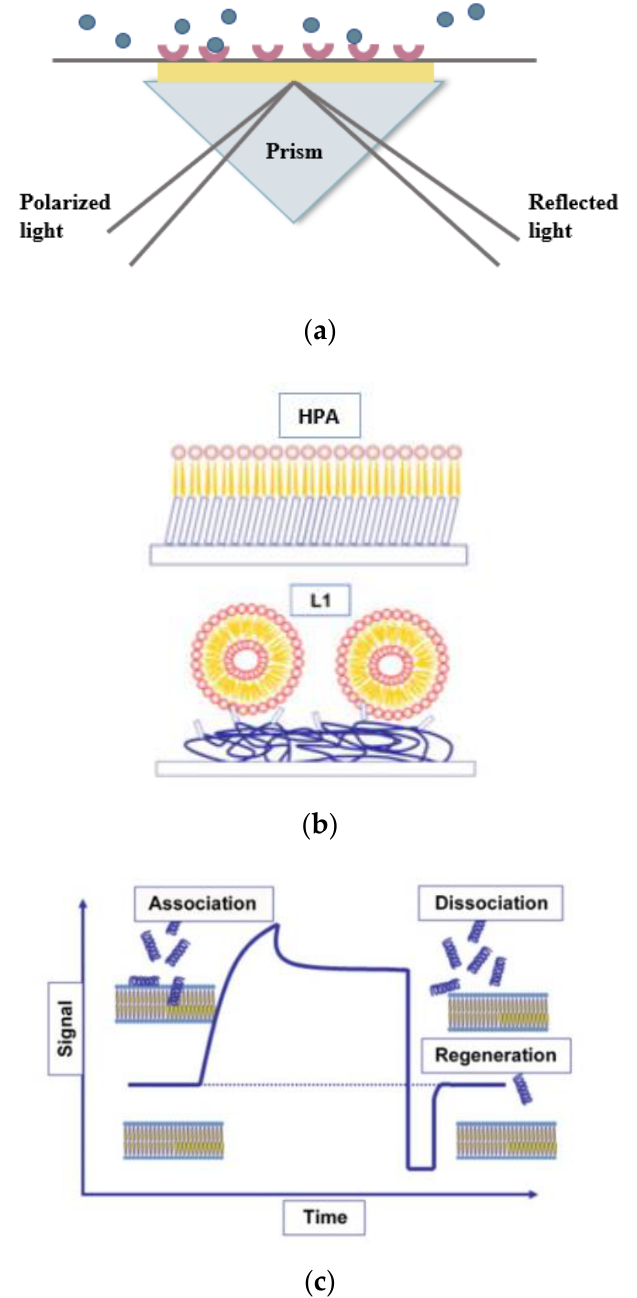
Figure 6. ( a ) The geometry of the surface plasmon resonance instrument ( b ) A schematic presentation of the HPA and L1 chips, adapted from [91]. ( c ) A sensorgram of the peptide–membrane binding including the association phase followed by the dissociation phase, reprinted with permissionfrom [91] under the Creative Commons Attribution 3.0 license (https://creativecommons.org/licenses/by/3.0/ (accessed on 30 May